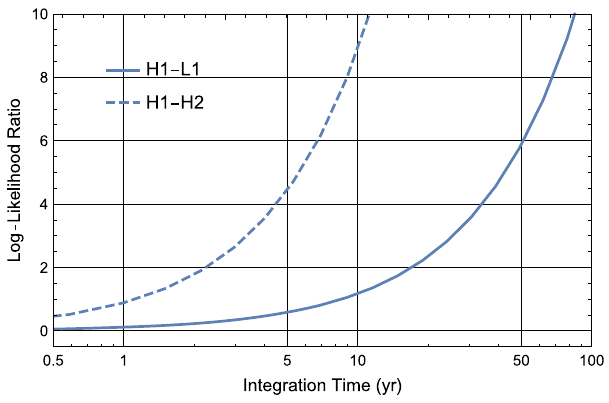
FIG. 5. Projected log-likelihood ratios ln R between the Fiducial and LowMetallicity background models, as a function of observation time with Advanced LIGO (H1-L1, solid curves). We assume that the underlying BBH background is given by the Fiducial model, with chirp mass M c ¼ 28 M ⊙ and local coalescence rate R 0 ¼ 16 Gpc − 3 yr − 1 following GW150914. We also include log-likelihoods for a network of colocated Advanced LIGO detectors (H1-H2, dashed